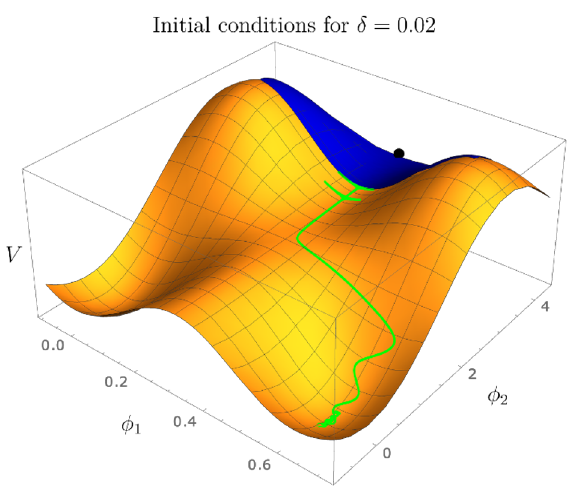
Figure 6 . We illustrate the amount of fine-tuning of initial conditions in a deformed hybrid potential with δ = 0 . 02 , α = 0 . 01 , γ = 0 . 011 and c 1 = 10 . In blue the patch of the potential around the saddle point (black dot) from which at least 60 e-folds of inflation will originate is shown. Moreover, in green two example trajectories of respectively 50 and 60 e-folds are